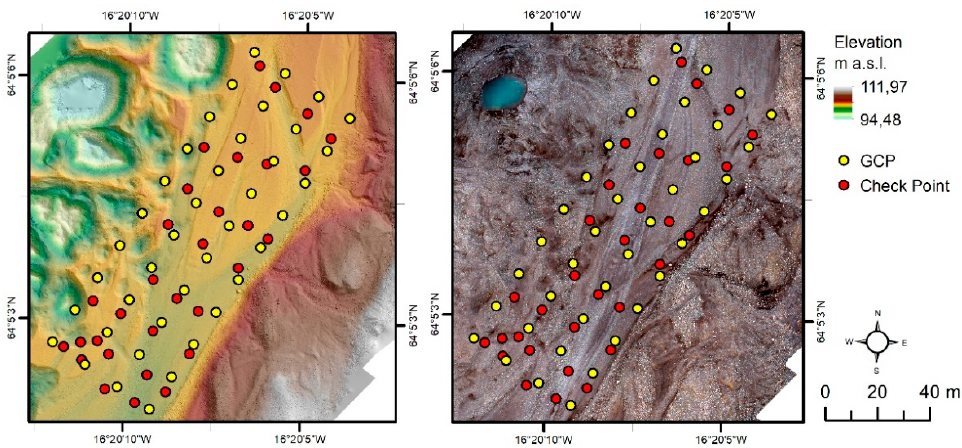
Figure 4. Example of end results of the processing: a DEM and an orthomosaic, with locations of GCPs and CPs.